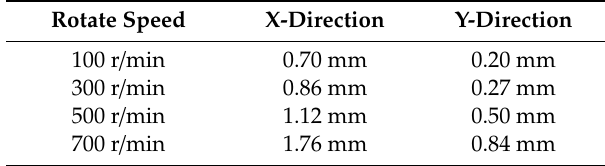
Table 8. Lateral displacement of BHA under di ff erent rotate speeds in numerical simulation.